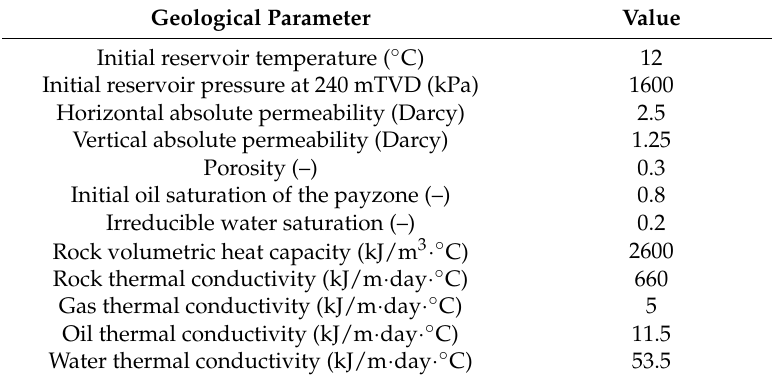
Table 1. Input properties used in the synthetic reservoir model. TVD: true vertical depth.